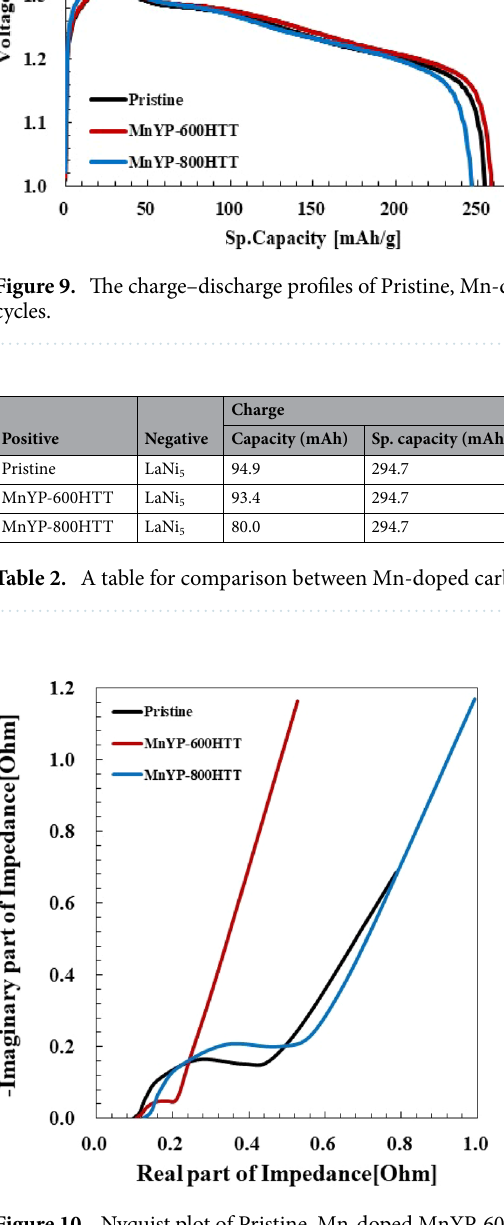
Figure 10. Nyquist plot of Pristine, Mn-doped MnYP-600HTT and